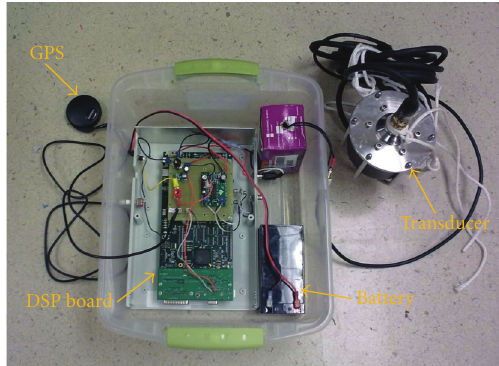
Figure 3: The OFDM modem prototype with an attached GPS